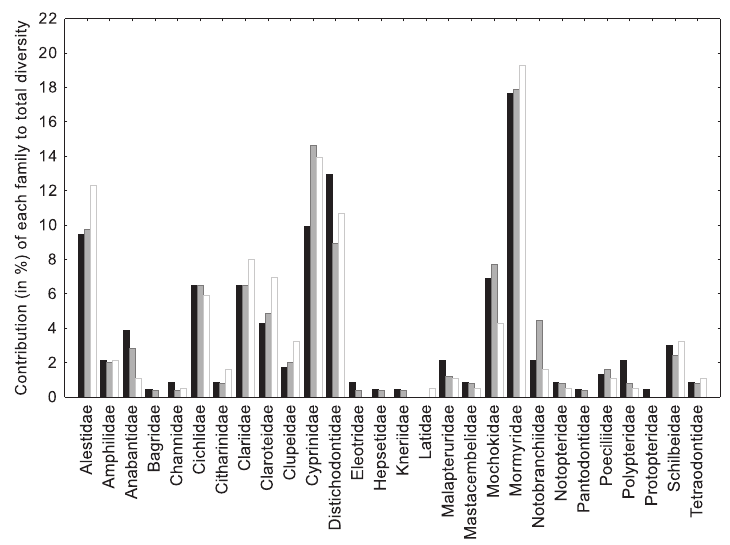
Fig. 2. Graph of the relative contributions of every family to the species richness in each basin explored: Itimbiri (black), Aruwimi (grey) and Lindi/Tshopo